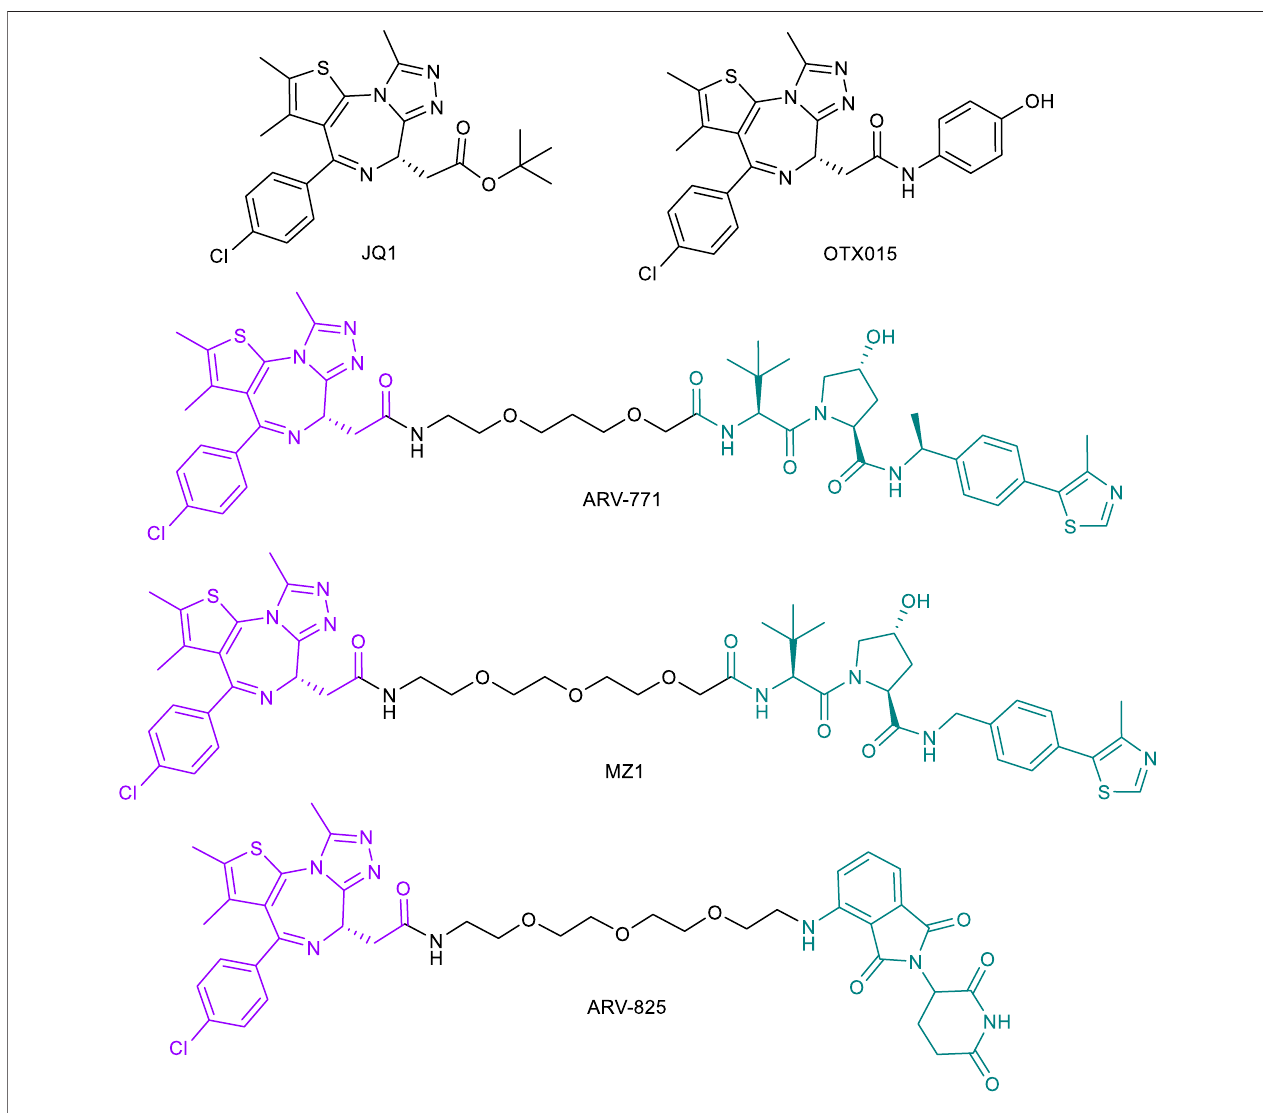
FIGURE 5 | Key BET protein small molecule inhibitors and BET-targeted PROTACs.